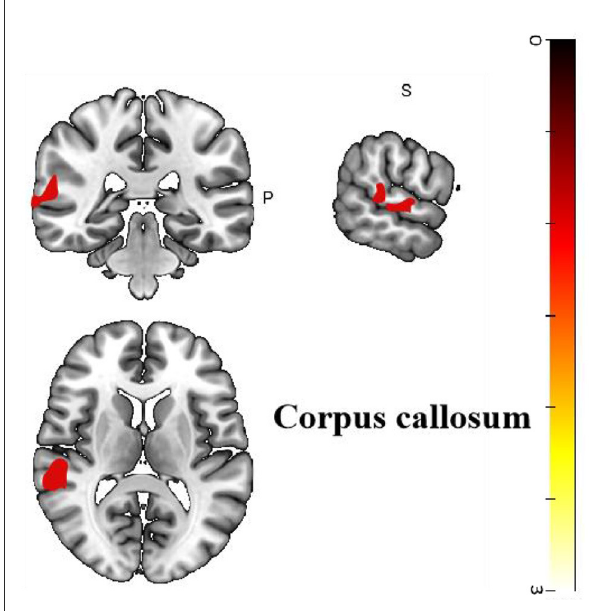
FIGURE4 Regional differences in gray matter between migraine patients and healthy controls before acupuncture